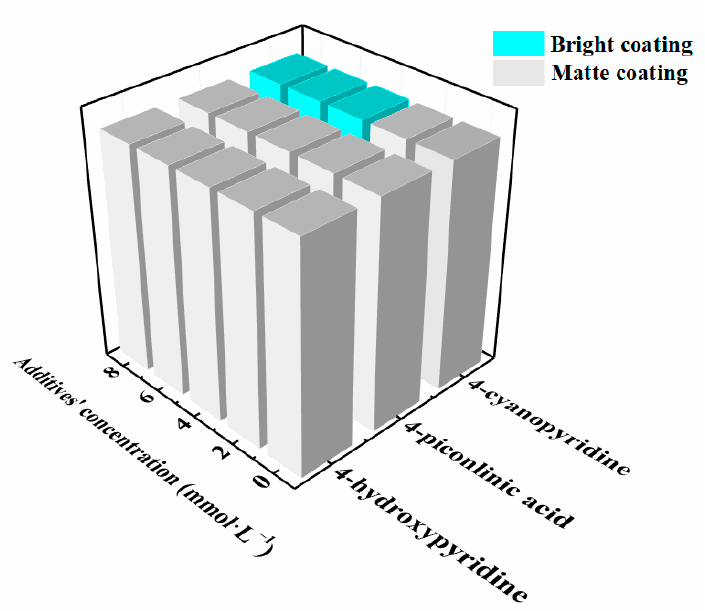
Figure 6. The statistical results of the quality of the Al-Mn coatings electrodeposited at 303 K in EMIC-AlCl 3 -MnCl 2 containing no, 4-hydroxypyridine, 4-picolinic acid, and 4-cyanopyridine at different additive concentrations (2 mmol · L − 1 , 4 mmol · L − 1 , 6 mmol · L − 1 , and 8 mmol · L − 1 ). The cyan represent that the deposited Al-Mn coatings are